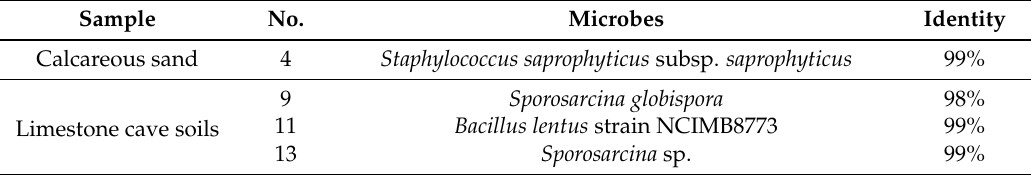
Table 1. Identification of microbial strains isolated from limestone cave and calcareous sand.